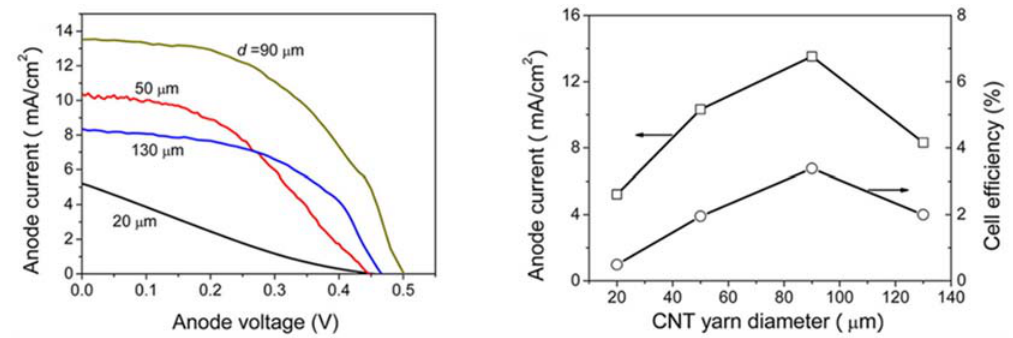
Figure 5. The anode current as a function of the Pt-CNT yarn diameter ( left ), and the corresponding fiber solar cells efficiency (right ). Adapted from Zhang et al. 2012. Reproduced with permission from reference [86].